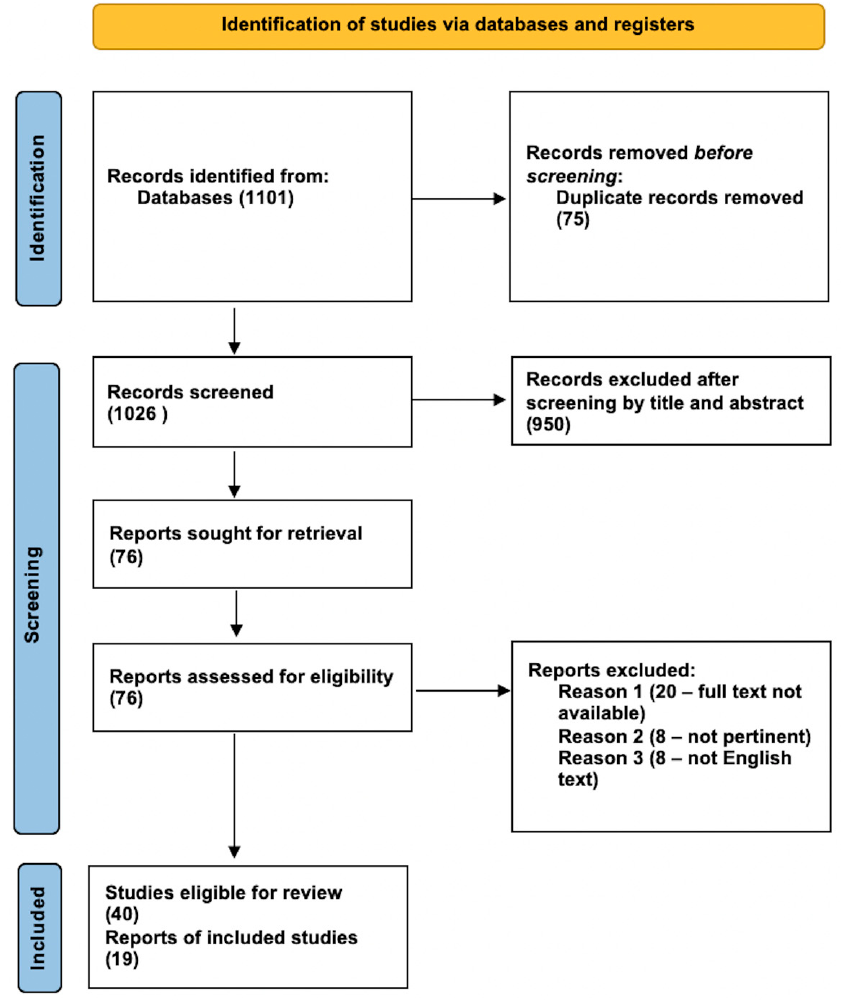
Figure 1. Flow diagram of the results of this systematic review according to PRISMA guidelines.